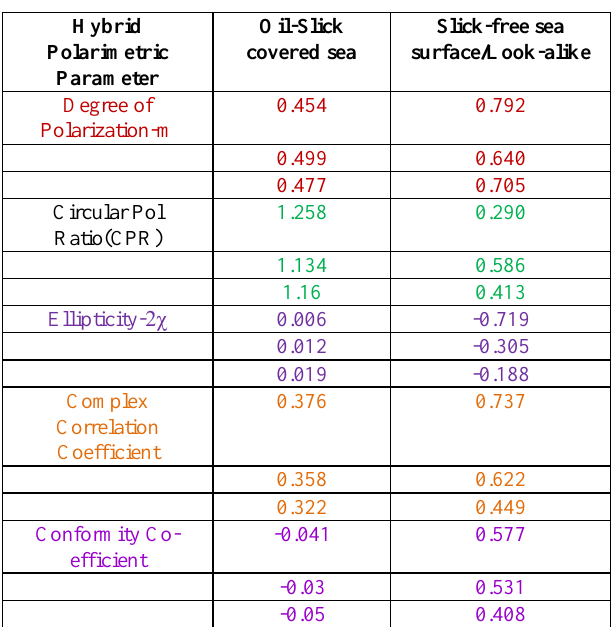
Table 2: Hybrid Polarimetric Parameters derived from RISAT-1 cFRS-1 for oil-slick and look-alike signatures(AOI-based)